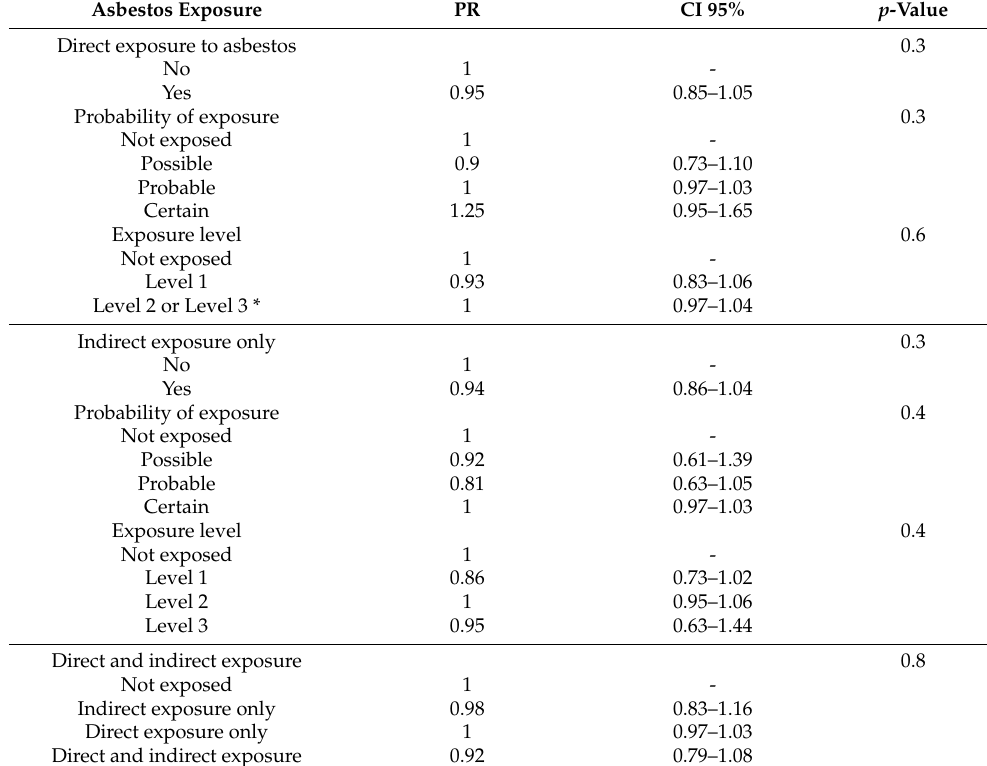
Table 7. Asbestos exposure and histological subtype, multivariate analysis ( N =